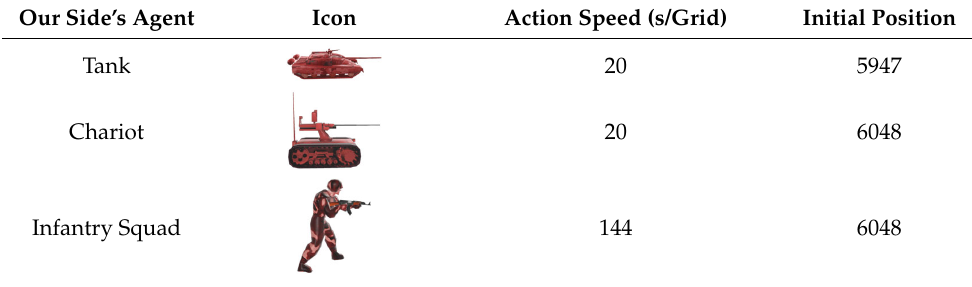
Table 2. Our side’s agents and their details.